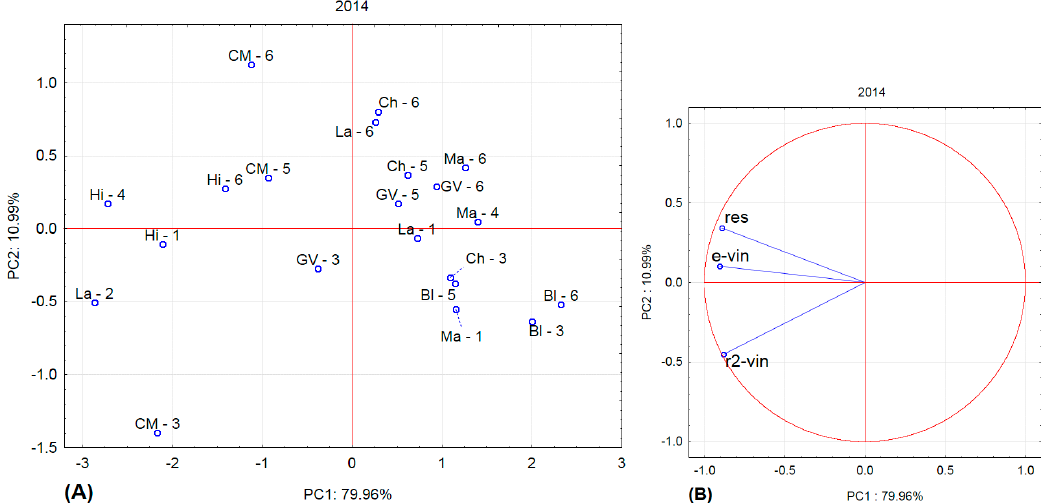
Figure 5. Principal component analysis for 2014. ( A ) projection of varieties and localities into component plane; ( B ) projection of component weights of stilbenes.